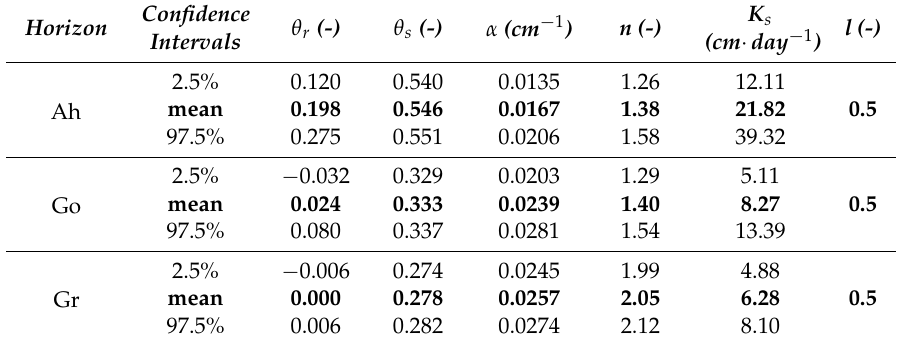
Table 2. Initial parameter set of the soil hydraulic properties determined using the evaporation method (horizons Ah, Go, and Gr/C). The mean and 2.5% to 97.5% confidence intervals are